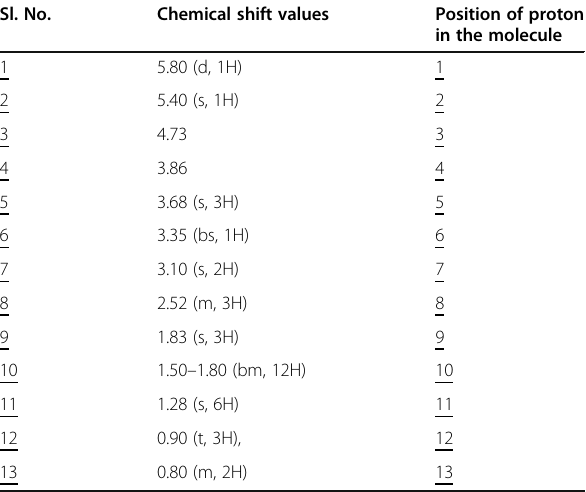
Table 6 1 H NMR in table format Sl. No.